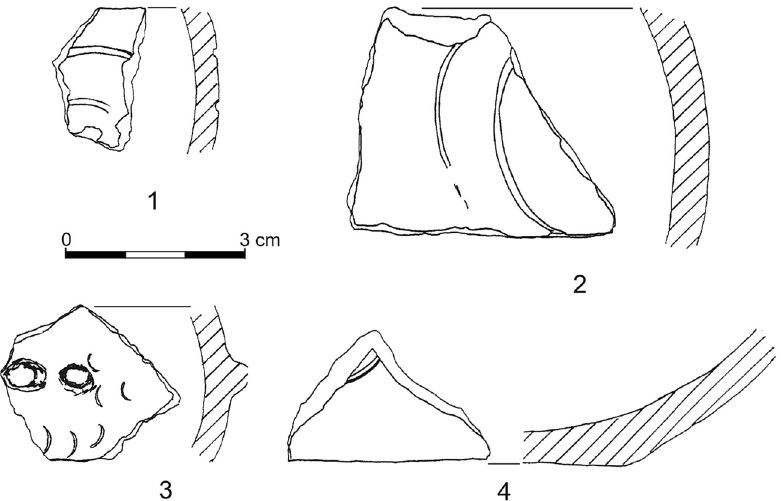
Figure 2: Ż erków, com. Gnojnik, site 1. Pottery of early LBK ( 1 – 4 ) found during AZP survey ( AZP sheet No. 106 – 63 – Archive of Voivodships O ffi ce for the Protection of Monuments in Krakow, delegation in Tarnów )